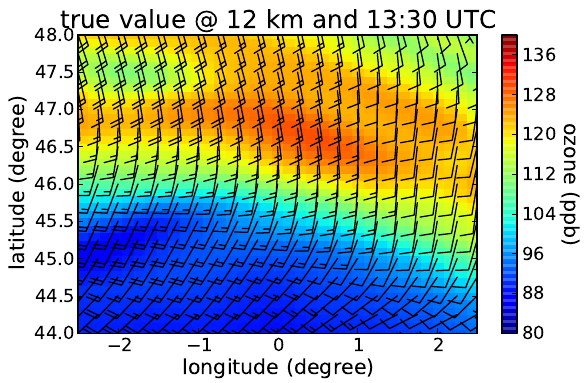
Fig. 14. The temporal change caused by advection. This figure depicts the scene at the end of the measurement period. In addition, horizontal wind speed at 12km altitude has been added using barbs, whereby half a line indicates 5ms − 1 and a full line 10ms − 1 horizontal wind speed.